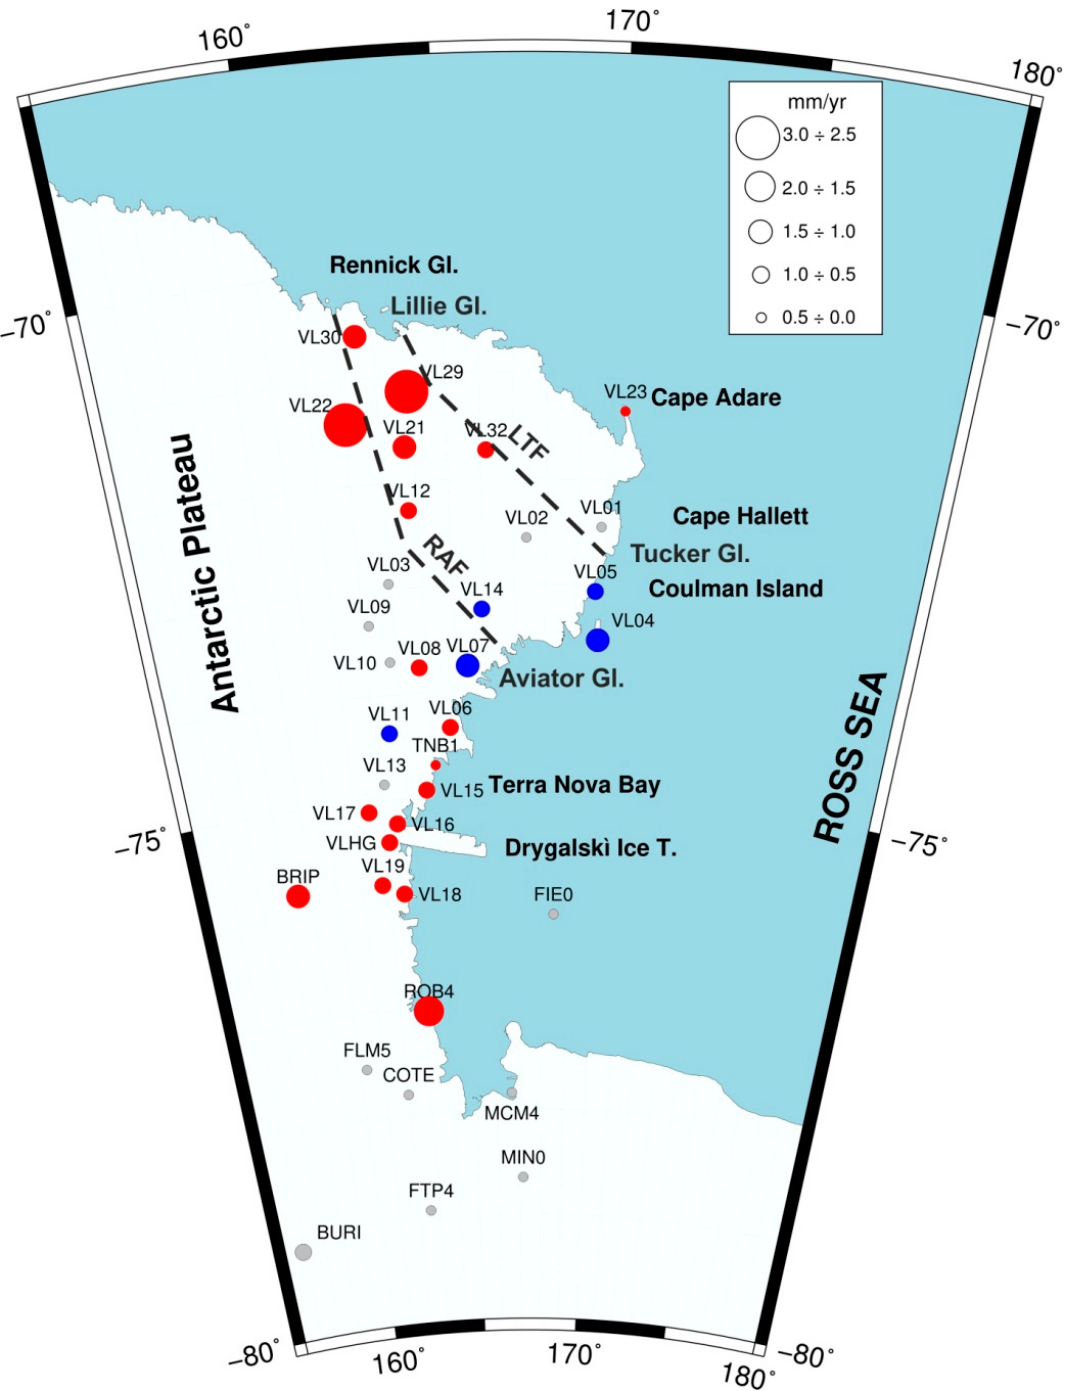
Figure 6. Vertical rates (mm/yr) detected in Victoria Land. Red dots denote uplifting sites, blue dots denote subsiding sites. Gray dots show not significant movements following the ± σ criteria. LTF: Lillie–Tucker Fault; RAF: Rennick–Aviator Fault.